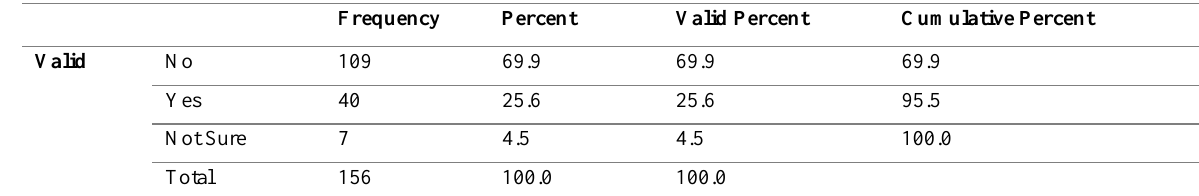
Table 9: Perceived risk of MyCO